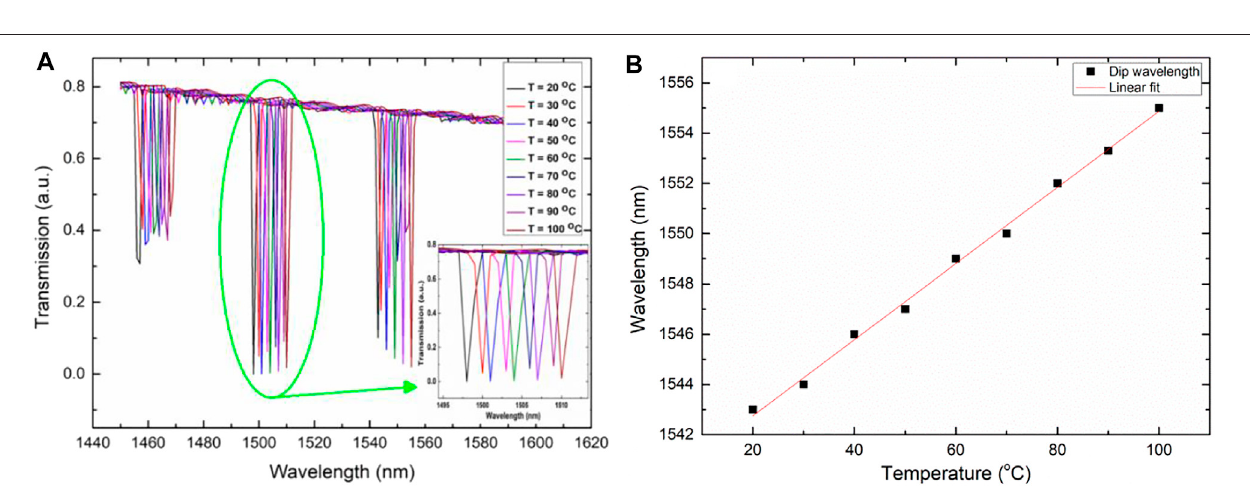
FIGURE6|(A) Transmissionspectraofthesensor with55%porosity atdifferenttemperaturesvaryingfrom20to100 ° C. Theinsetshowstheenlargedviewofthe transmission spectrum near the 1,505 nm wavelength. (B) Variations in the dip wavelength around 1,550 nm with different temperatures.